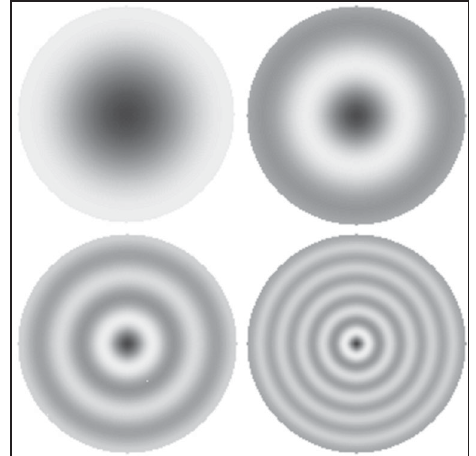
Figure 1. Examples of radial fre- quency stimuli (e.g., 0.25, 0.5, 1.0, and 2.0 cpd) which were originally calibrated to be seen at a distance of 150 cm on the 21"